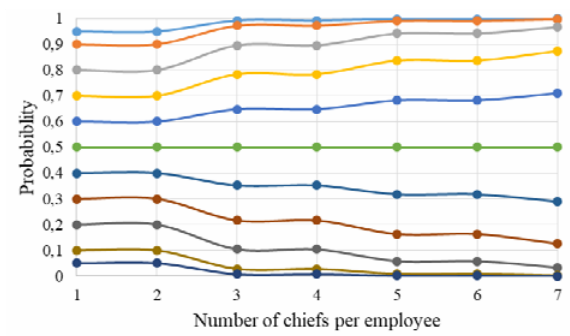
Figure 3: Effects of the number of elements in the quality of a decision-making